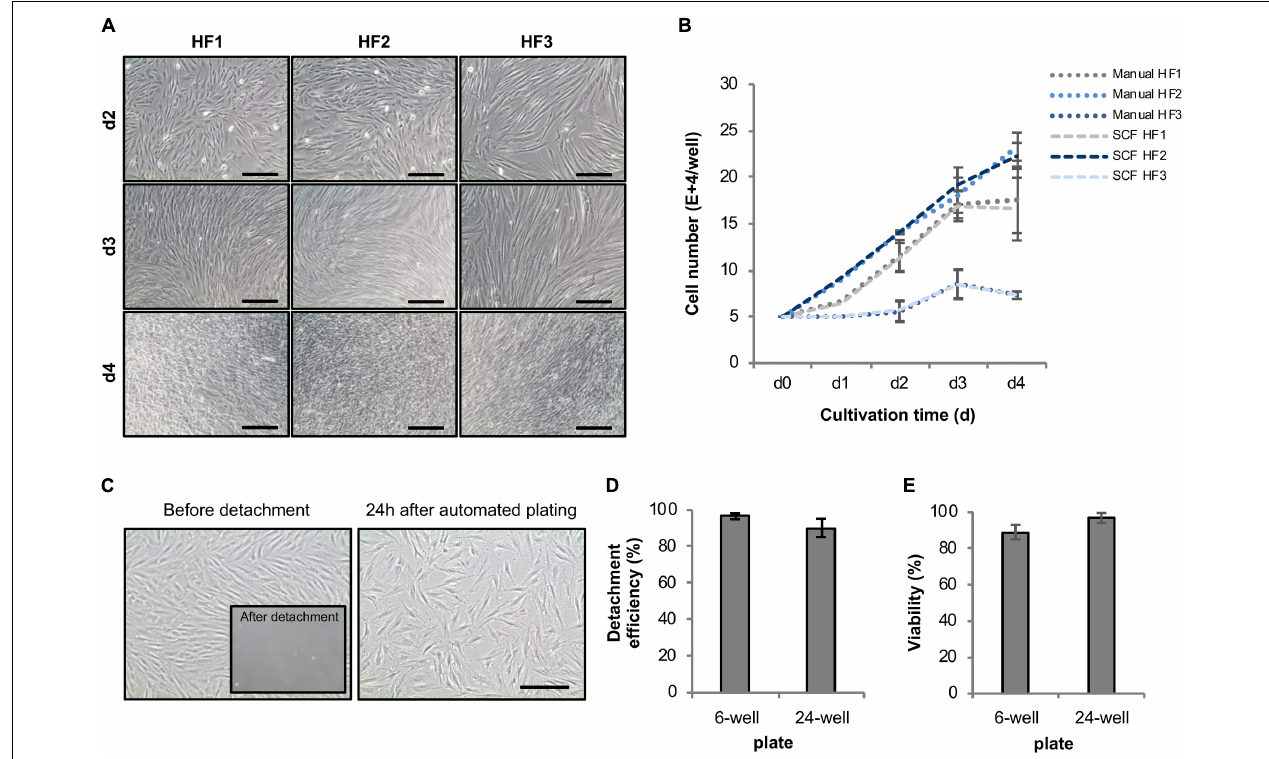
FIGURE 4 | Development of an automated expansion and plating protocol for human fibroblasts. (A) Representative phase-contrast images of different HF lines automatically cultivated in 6-well plates using the StemCellFactory. (B) Average cell number of automatically vs. manually cultivated human fibroblast lines over the duration of 4 days (mean ± SD; n = 3). (C) Representative phase-contrast images of HF cells before and after enzyme-based, automated detachment and one day after automated re-plating of 80,000 HF (sub-confluence density) cells into a well of a 24-well plate. (D) Mean detachment efficiency was determined by quantifying the amount of cell retrieved by automated detachment versus the number of cells remaining on the plate and collected by subsequent manual detachment [6-well plates, mean ± SD ( n = 4); 24-well plates, mean ± SD ( n = 5)]. (E) Cell viability of detached cells was determined via trypan blue staining [6-well plates, mean ± SD ( n = 6); 24-well plates, mean ± SD ( n = 5)]. SD, standard deviation; SCF, StemCellFactory; HF, human fibroblasts. Scale bar = 200 µ